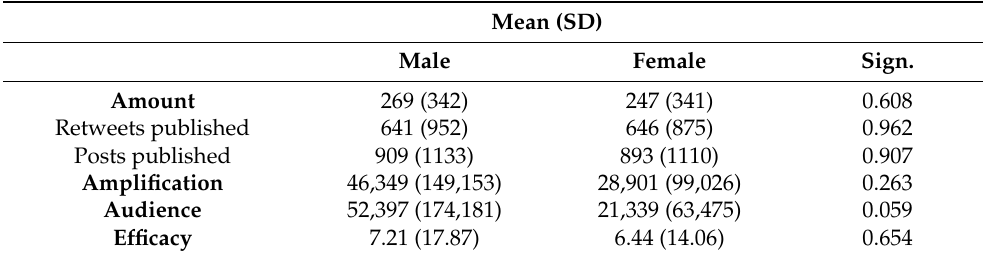
Table 3. Mean values of amount of tweets, number of followers and efficacy of Spanish Members on Twitter by